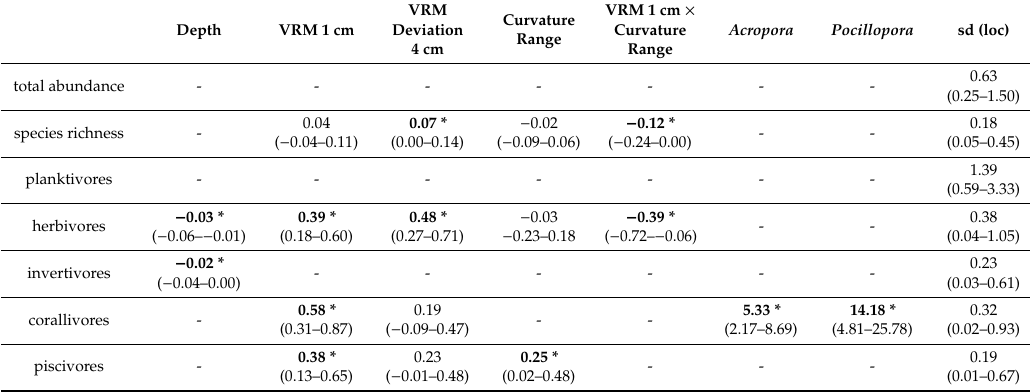
Figure A1. Conditional means of fish abundance at di ff erent geographic locations, French Frigate Shoals (FFS), Laysan Island (Laysan), Lisianski Island (Lisianski), Pearl and Hermes Atoll (PHR), Midway Atoll (Midway) and Kure Atoll (Kure), based on the respective final models for ( a ) the total fish abundance, ( b ) species richness and the abundances of ( c ) planktivores, ( d ) herbivores, ( e ) invertivores, ( f ) corallivores and ( g ) piscivores. Table A1. Parameter estimates for the generalized linear models with the negative binomial probability distribution with the log link function. Estimates of coe ffi cients for the fixed terms (depth, standardized mean VRM at 1-cm resolution, standardized mean VRM deviation at 4-cm resolution, standardized curvature range, interaction between the standardized mean VRM at 1-cm resolution and the standardized curvature range and percent covers of Acropora and Pocillopora corals) are shown along with their 95% CI in the parentheses. The estimates whose 95% CI did not overlap with 0 are shown in bold and marked with asterisks (*). Fixed terms that were not included in the final model for any of the response variables are not included in this table. Estimates of standard deviation for the grouping factor, geographical locations, are also shown (sd(loc)) along with their 95% CI in the parentheses. Conditional means of each response variable for di ff erent geographical locations are also shown in Figure